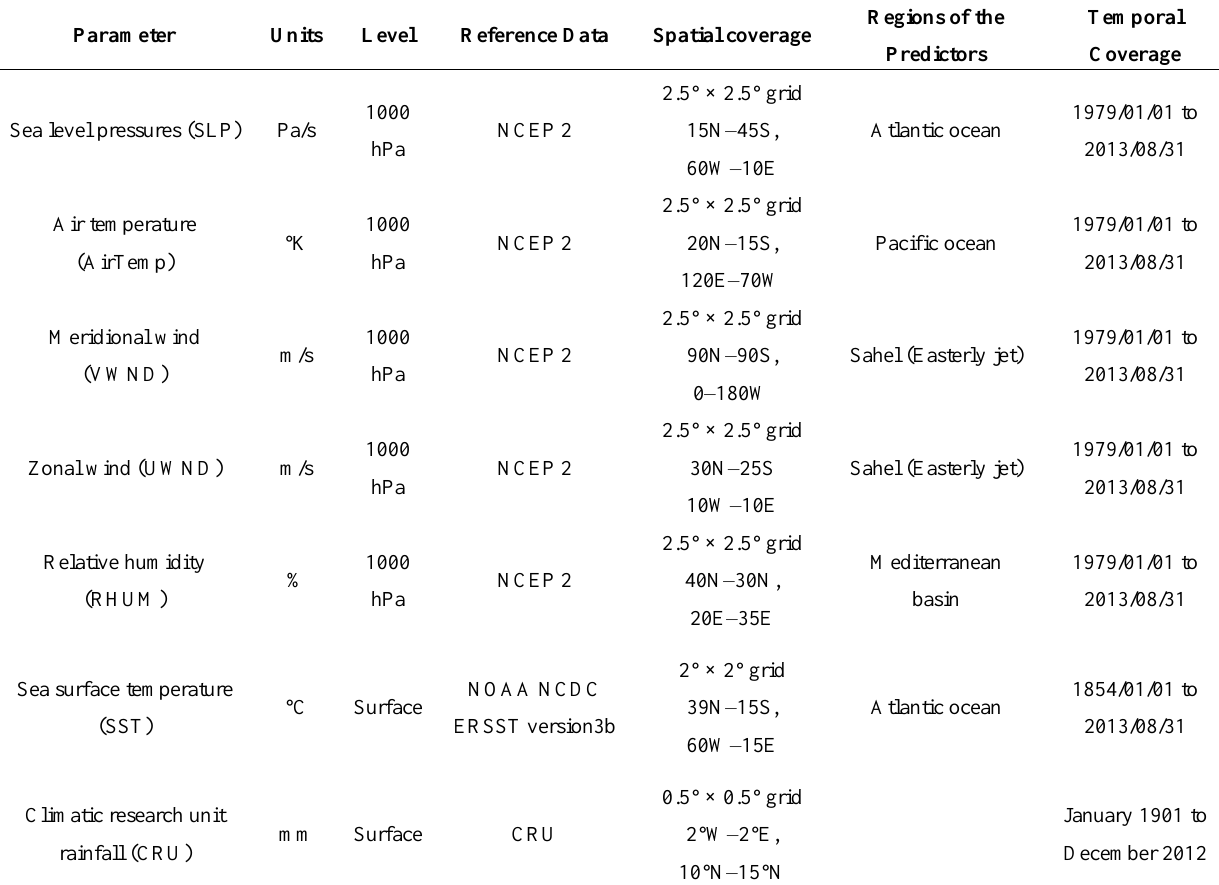
Table 2. Description of atmospheric